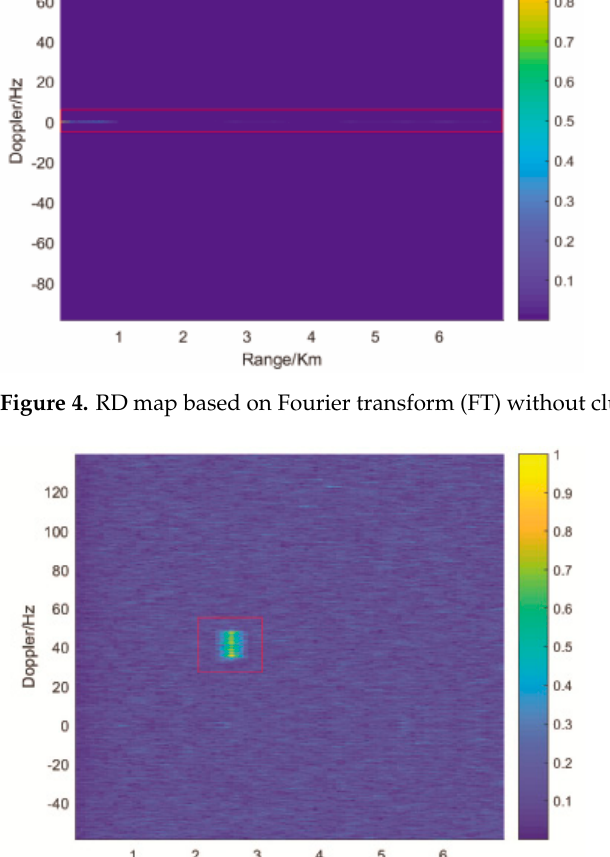
Figure 4. RD map based on Fourier transform (FT) without clutter cancellation.